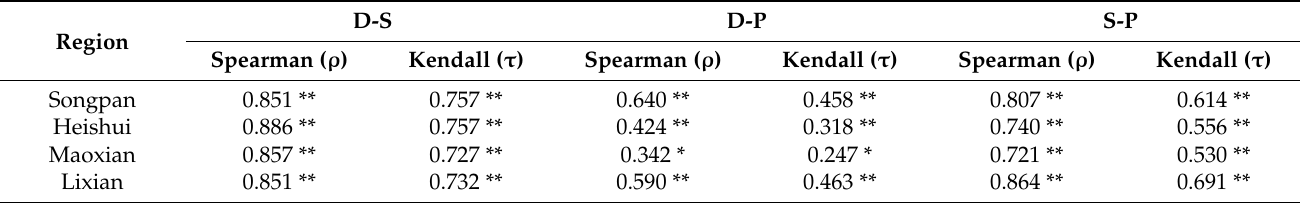
Table 5. Correlation coefficients among drought